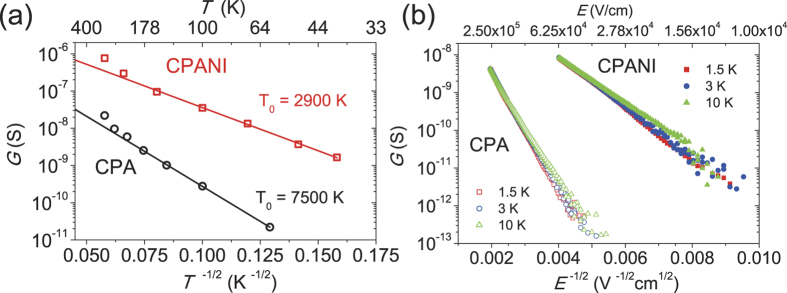
ES-VRH behaviors of CPA and CPANI nanofibers.(a) The temperature dependence of the Ohmic conductance at low bias voltages follows the ES-VRH, G(T) ∝ exp[−(T0/T)]1/2 at T < 180 K and deviates from the ES-VRH at T > 180 K. (b) The bias electric field dependence of the non-Ohmic conductance at low temperatures (T < 10 K) and high voltages (V > ~ 1 V) shows the characteristic of the ES-VRH, G(E) ∝ exp[−(E0/E)]1/2.